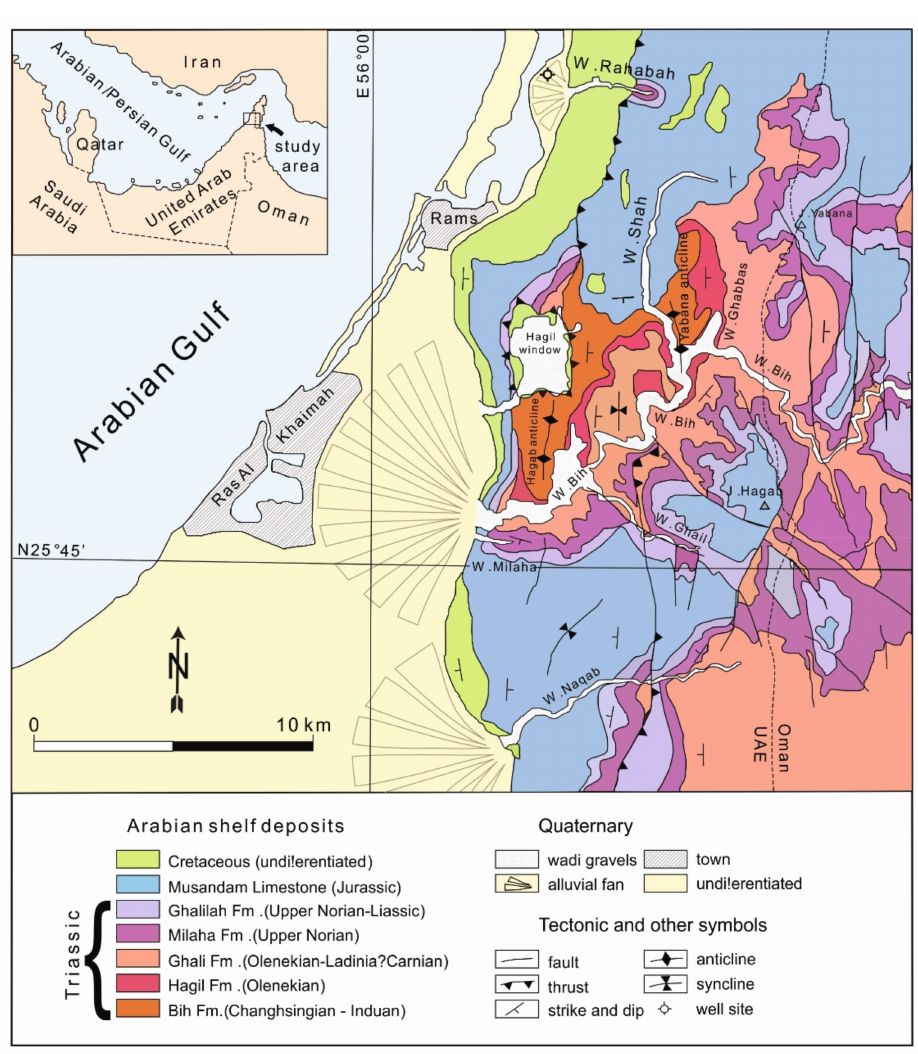
Figure 1. Location of the study area, northwest of the UAE (marked in green). Modified from